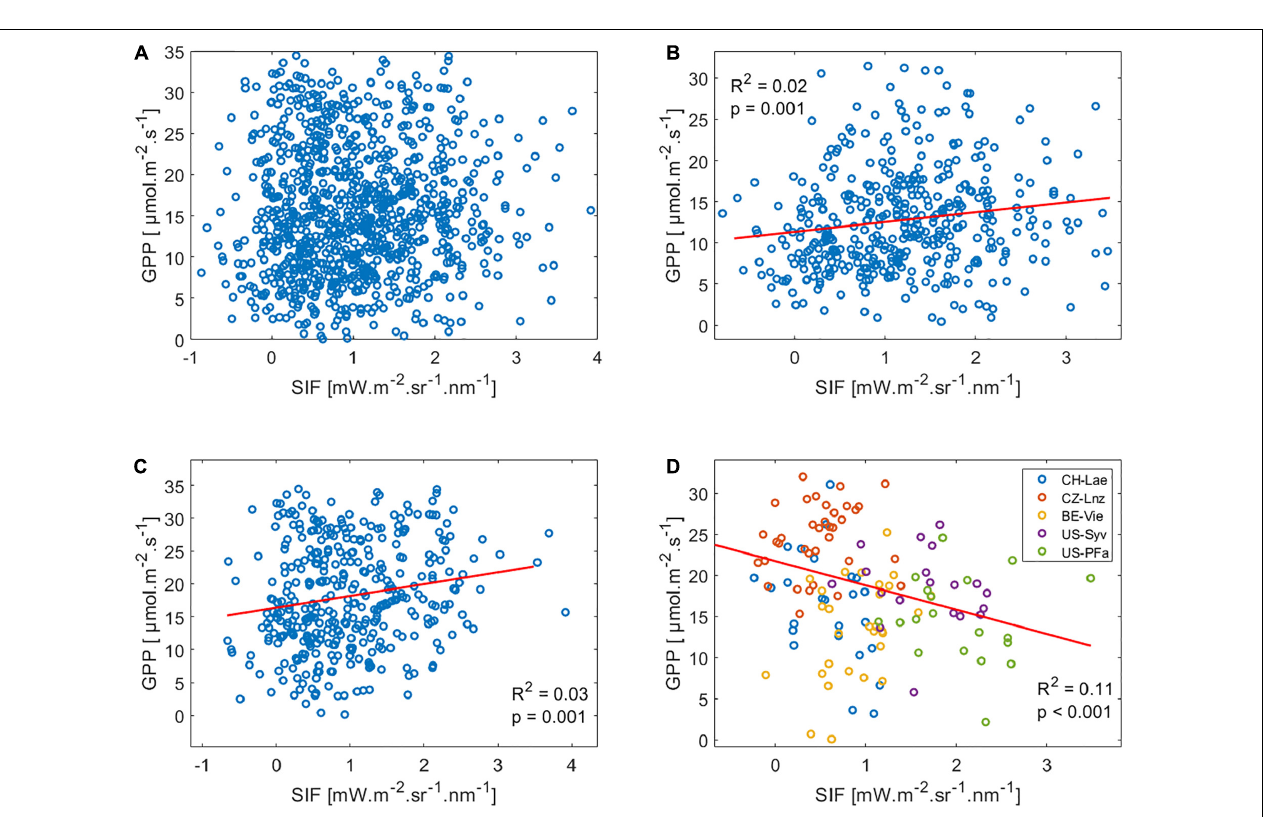
FIGURE 2 | Results of the sites with a significant hyperbolic correlation at half-hourly resolution. Significant correlation happened at (A) SE-Nor and (B) US-Me2. The red line represents the hyperbolic fit.